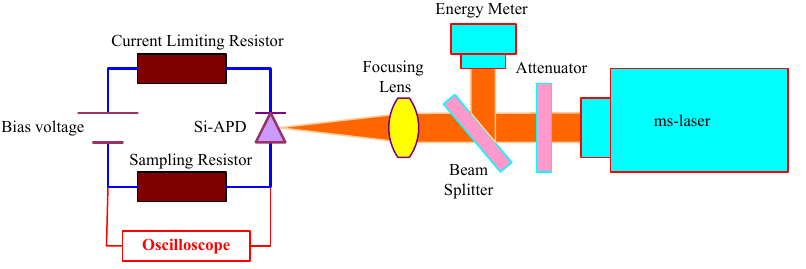
Figure 1. Schematic of the experimental configuration. The test samples were Si-APDs with the reach-through structure shown in Figure 2. The surfaces of these detectors are coated with a standard antireflection film, and the active area is 0.5 mm 2 .